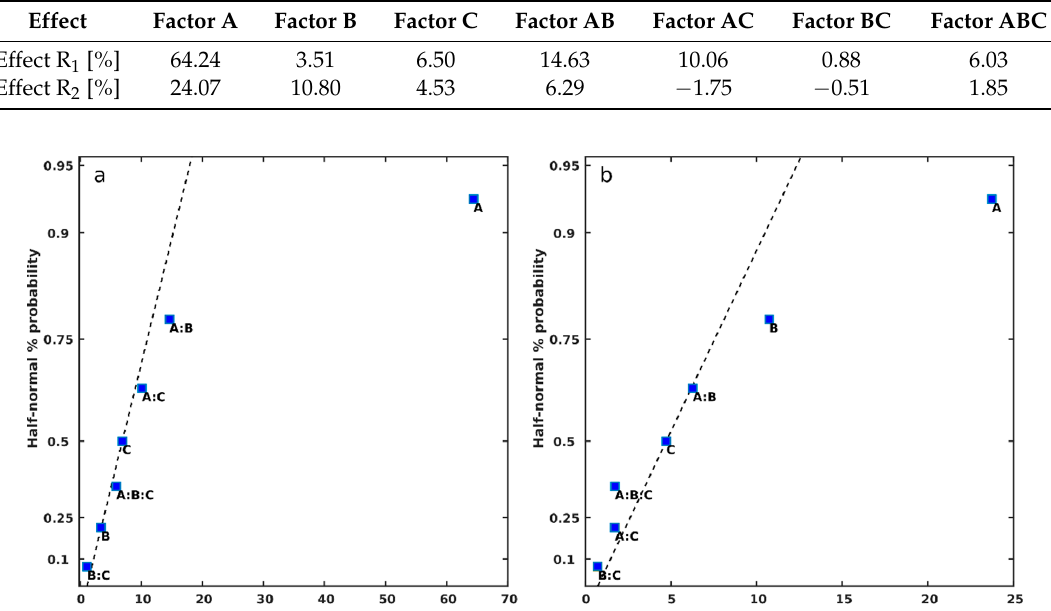
Figure 1. Half normal plot of effects [%], de-O ( a ) and de-N ( b ).